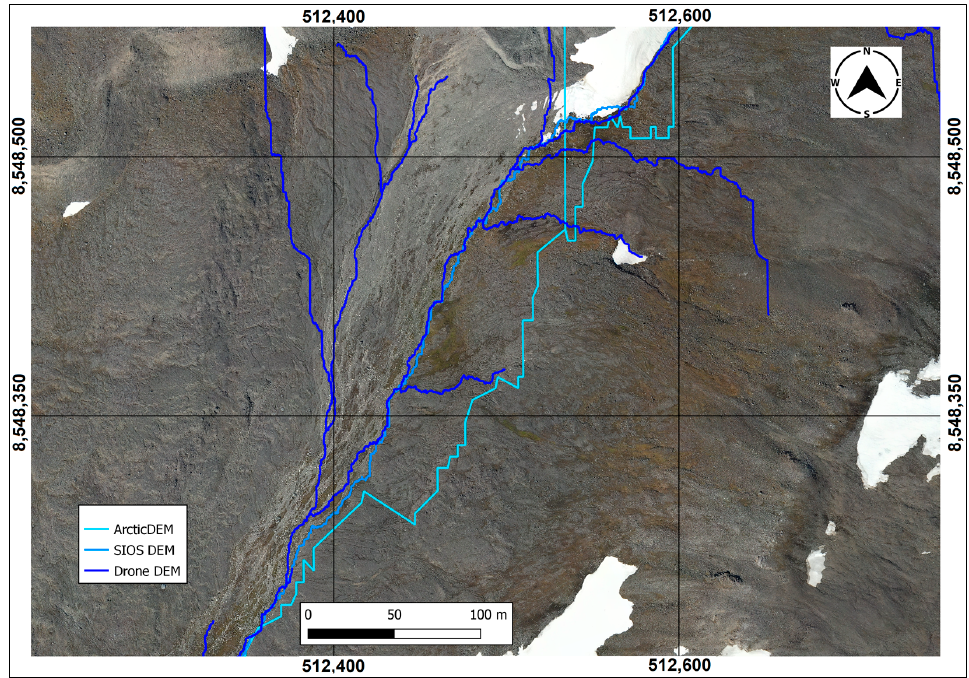
Figure 11. Comparison of stream delineations using different DEMs in Ariebekken.